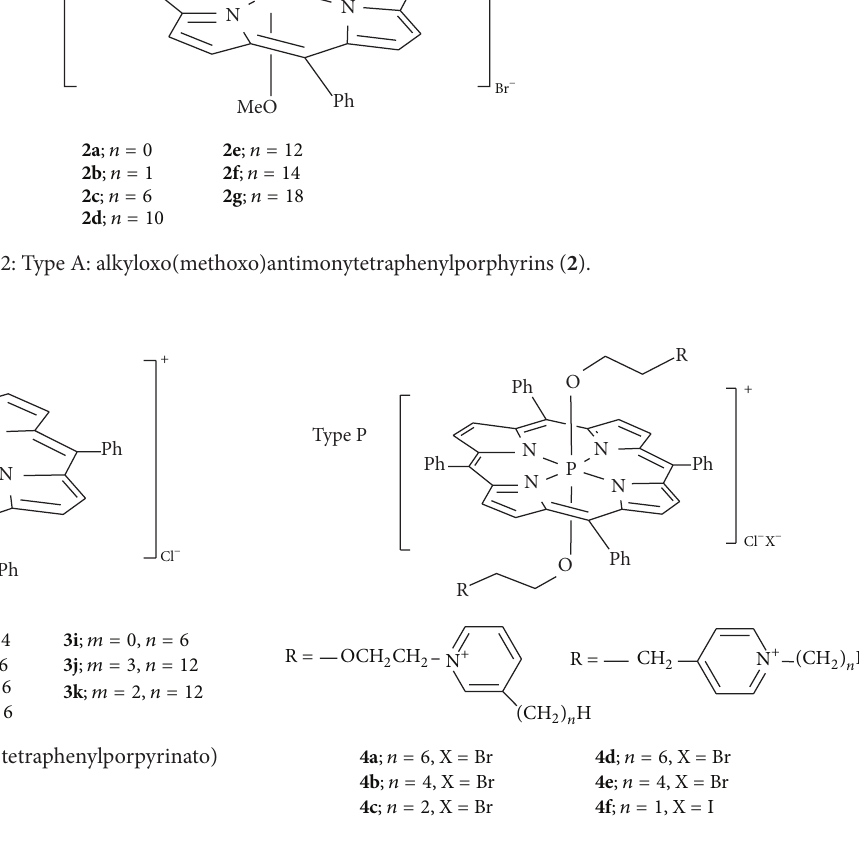
Scheme 4: Type P: pyridinio-bonded tricationic phosphorus- porphyrins ( 4